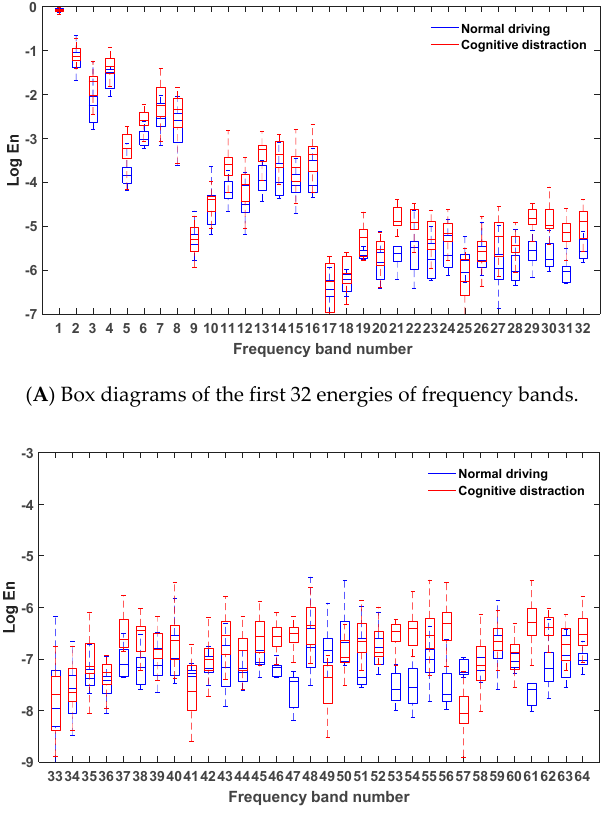
( B ) Box diagrams of the last 32 energies of frequency bands. Figure 5. Box diagrams of the energies of frequency bands under different driving states. Figure 5. Box diagrams of the energies of frequency bands under di ff erent driving